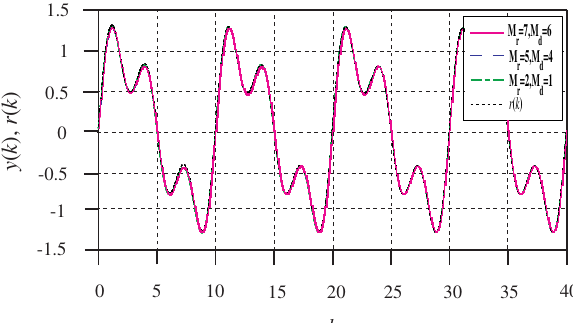
Figure 3. The reference signal and the outputs of the closed-loop system with different preview length.